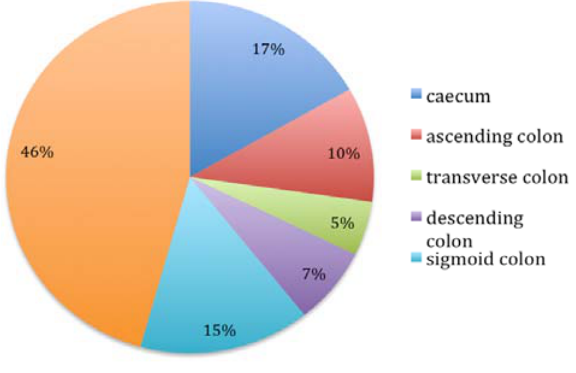
Figure 10 Colorectal cancer by anatomical tumour site.